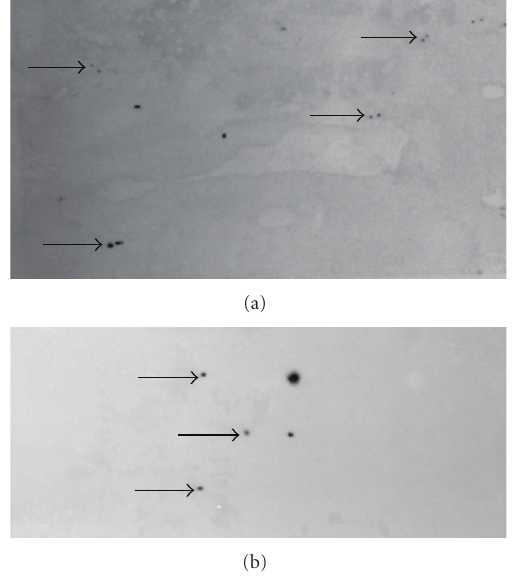
Figure 1: (a) 32P-labeled probes hybridized to sex-di ff erentiating genes on filters representing the BAC library for painted turtle (Chrysemys picta). Two-dot signals permit the gridding of multiple 384-well plates into the same space on the filters. The two-dot pattern permits the gridding of up to 72 384-well plates on one nylon filter. Arrows indicate successful hybridization of one of several probes applied concurrently to filters. (b) Clones identified as putative positives from hybridization with a probe for Dmrt1 regridded in duplicate onto a separate filter to be hybridized with a single probe as opposed to the multiprobe approach taken to initially identify positives. The secondary hybridization permits the identification of the probe that hybridizes to each positive. Arrows indicate three hybridizations that occurred on each of two identical arrays representing only positives collected from the initial large- scale hybridization. These arrays are printed side by side on the filter. Other hybridizations that were successful in only one array were rescreened to insure